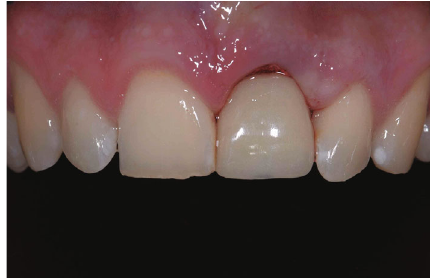
Figure 13: Clinical view after immediate implant placement and immediate provisionalization.